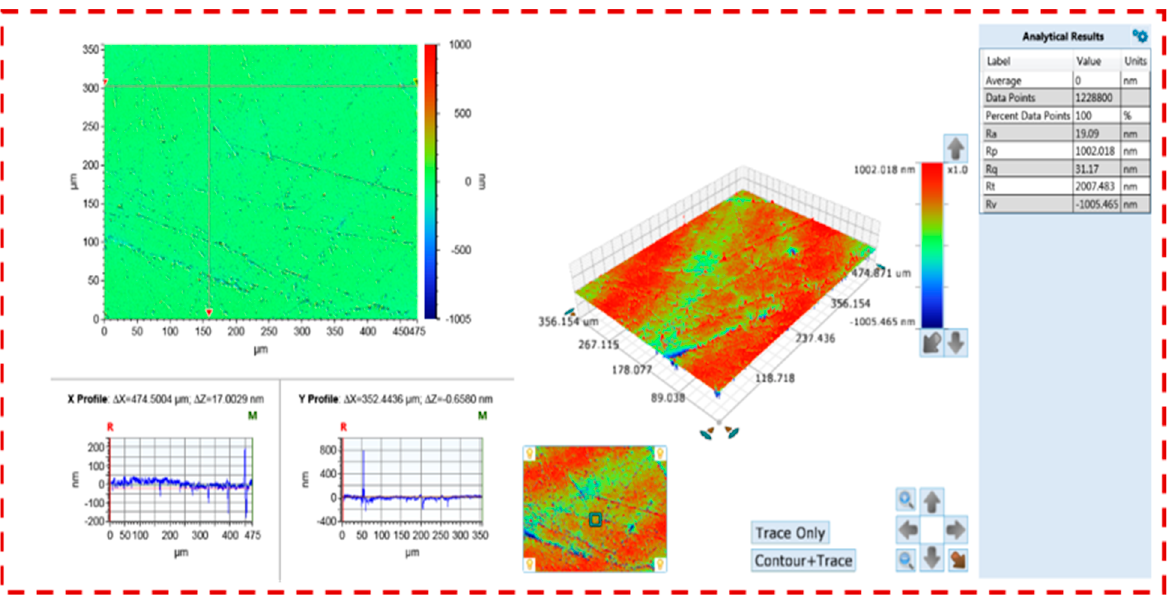
Figure 20. 2D and 3D morphologies and surface roughness of the Si-plane surfaces after being polished by the free abrasive particles.